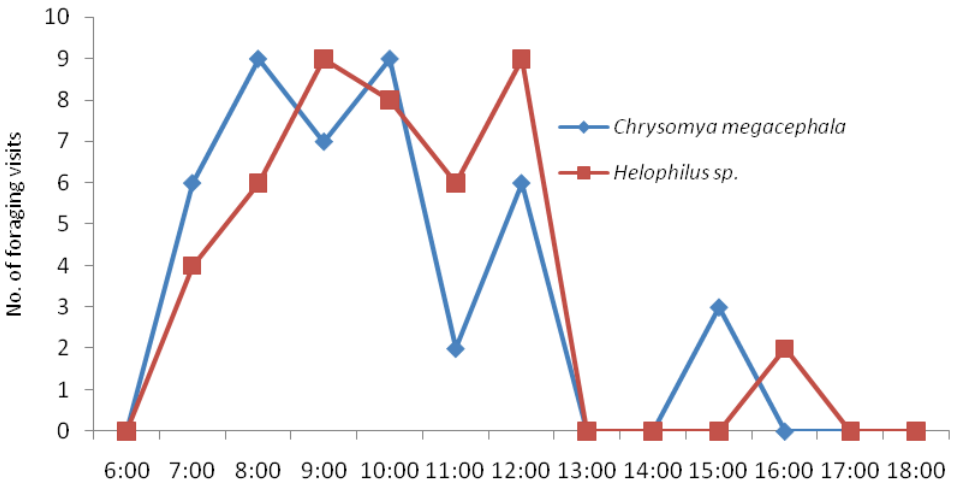
Figure 3. Hourly foraging activity of flies on Syzygium alternifolium